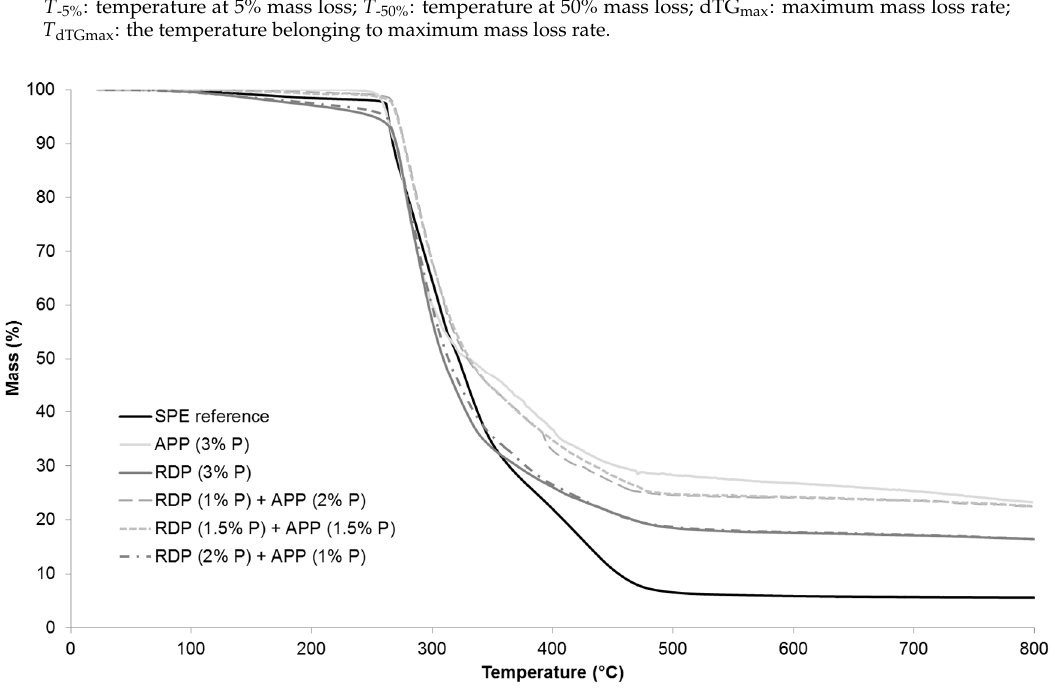
Figure 4. Full temperature range thermogravimetric analysis (TGA) curves of the reference and 3% P-containing SPE samples.